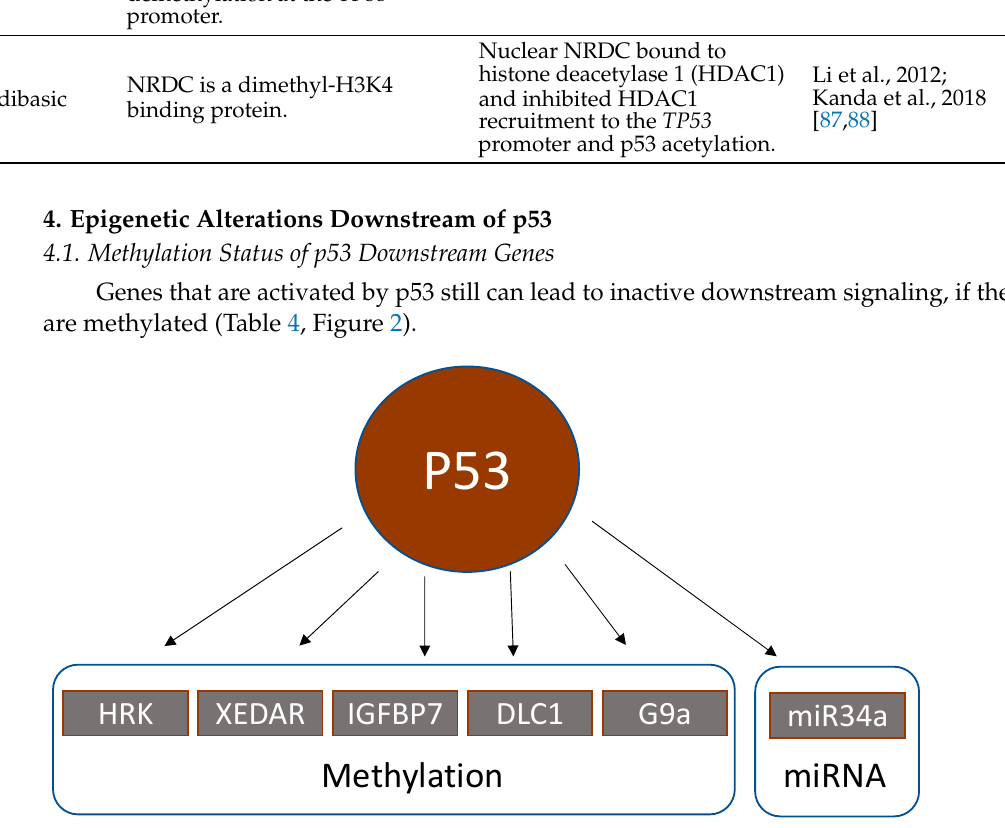
Figure 2. Epigenetics alterations downstream of p53.